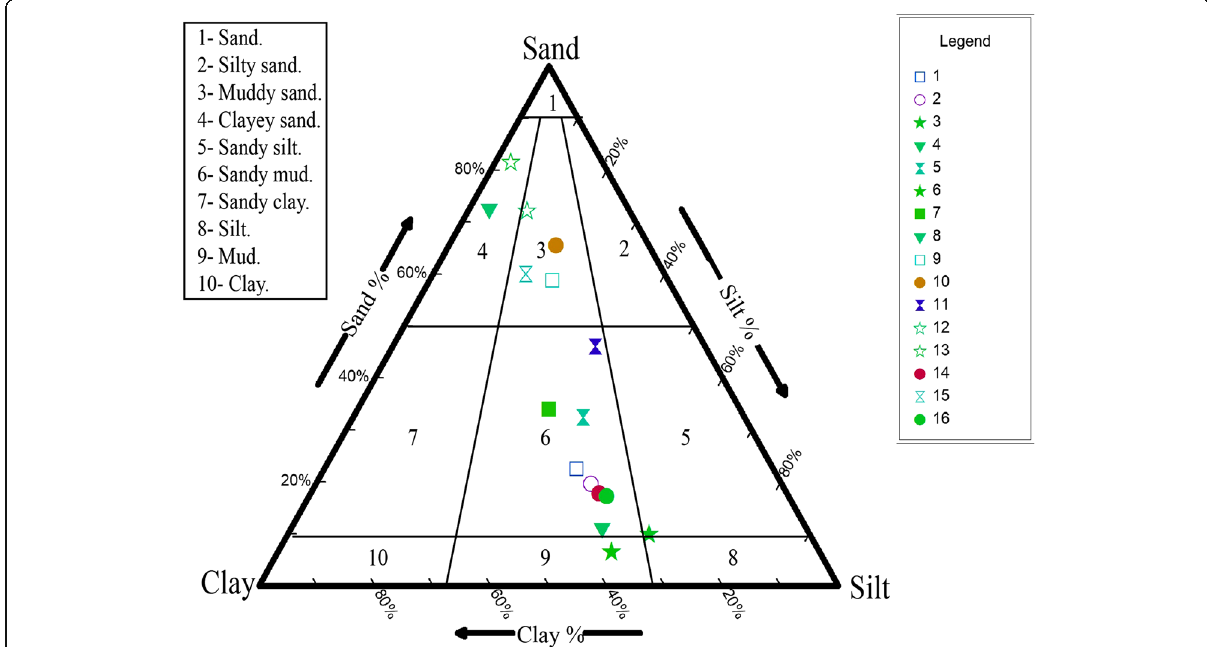
Fig. 4 Folk triangle diagram of soil